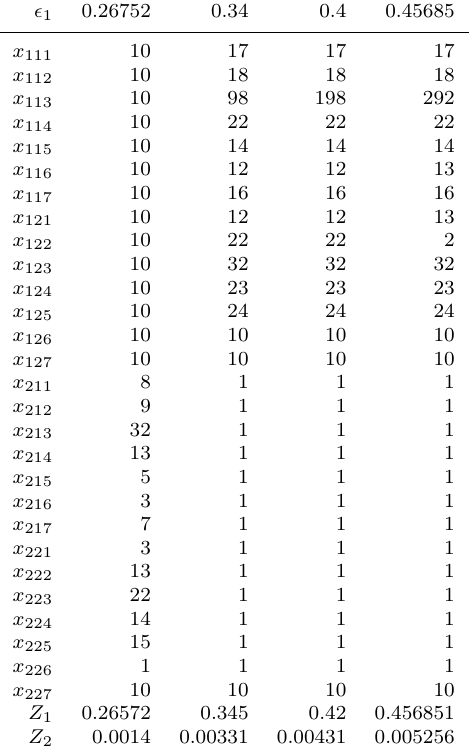
Table 9. Solutions of Z 1 and Z 2 for different values of (cid:15) 1